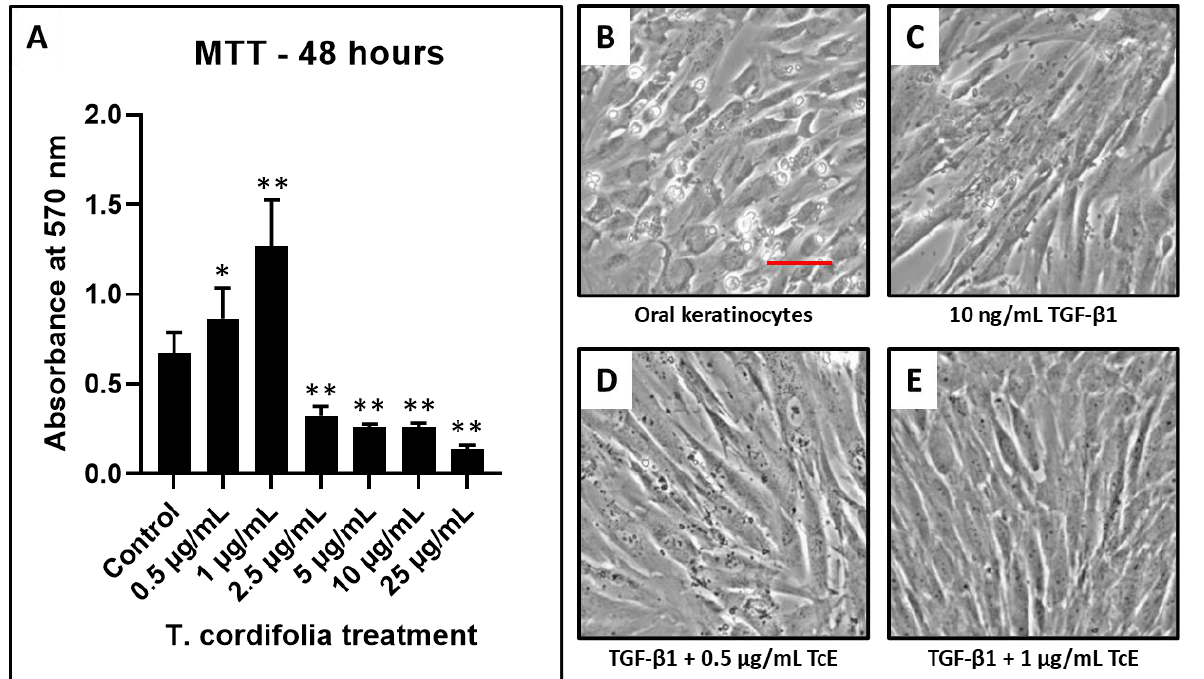
Figure 1. Cell viability by MTT assay and fibrosis induction in oral keratinocytes and TcE treatment. ( A ) MTT assay was performed to assess the viability of oral keratinocytes treated with various concentrations of TcE (0.5 µg/mL, 1 µg/mL, 2.5 µg/mL, 5 µg/mL, 10 µg/mL, and 25 µg/mL). ( B , C ) Photomicrographs of oral keratinocytes before and after fibrosis induction with TGF-β1. ( D , E ) Photomicrographs of fibrosis-induced oral keratinocytes treated with 0.5 µg/mL and 1 µg/mL of TcE. Scale bar = 100 µg/mL. TcE: T. cordifolia aqueous extract, TGF-β1: Transforming growth factor-beta 1. * p < 0.05, ** p < 0.001.